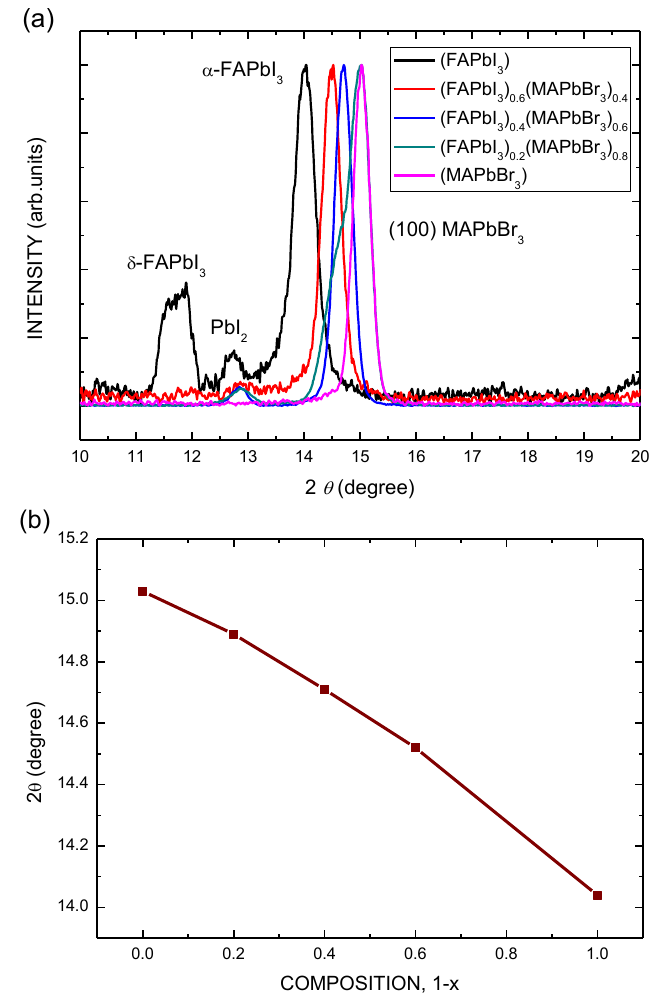
Figure 3. ( a ) X-ray diffraction (XRD) patterns of (FAPbI 3 ) 1−x (MAPbBr 3 ) x perovskite films with various compositions. ( b ) Relationship between degree of diffraction and composition of (FAPbI 3 ) 1− x (MAPbBr 3 ) x . compositions; ( b ) Relationship between degree of diffraction and composition of (FAPbI